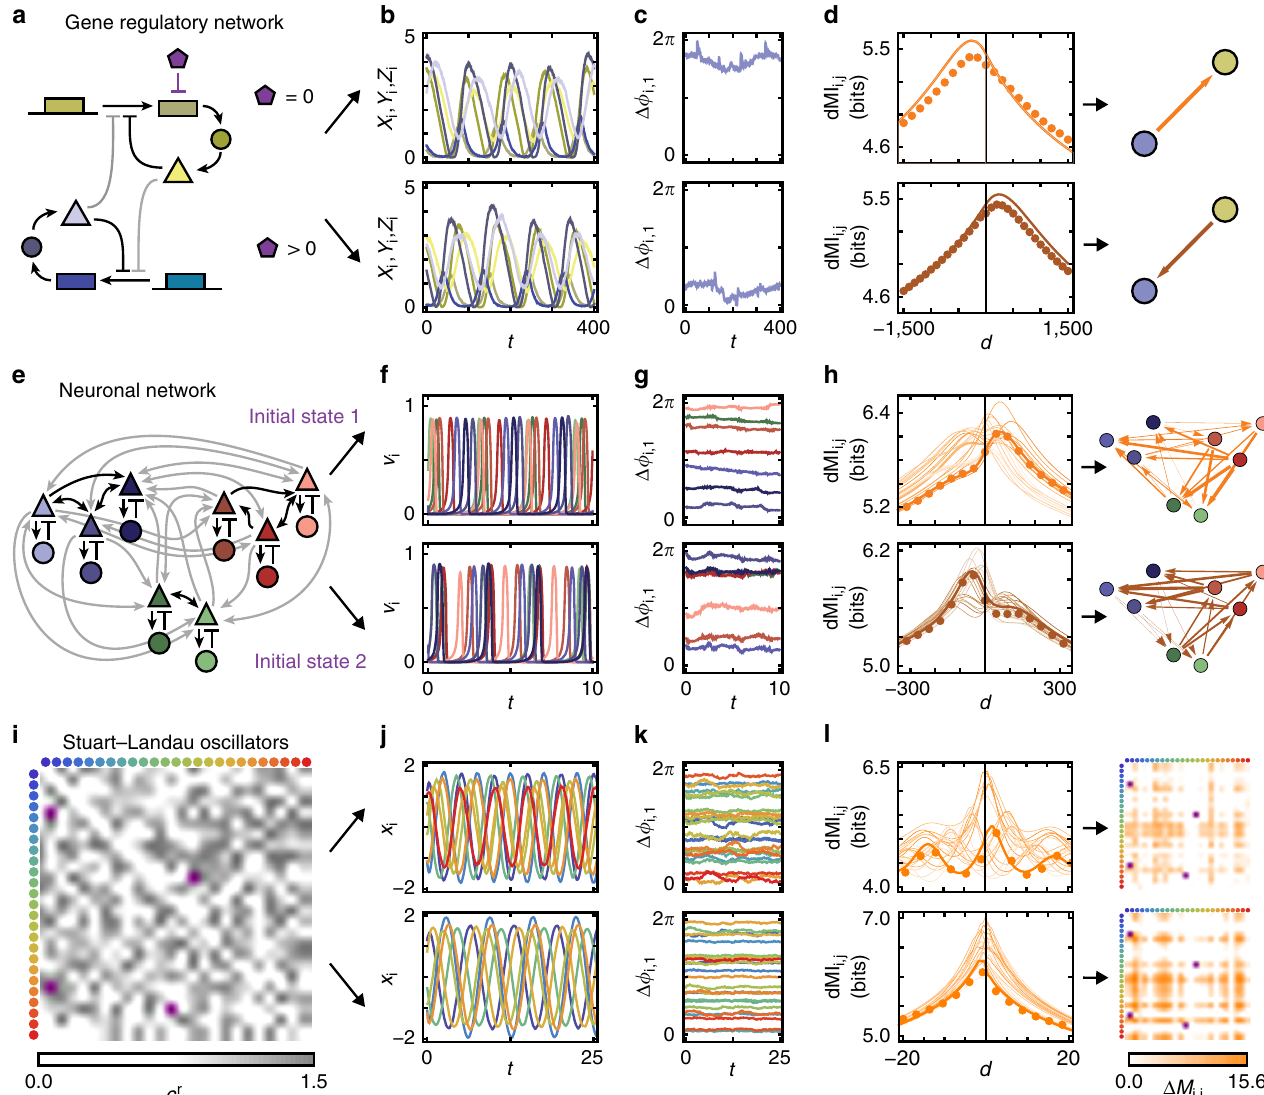
Figure 1 | Flexible information routing across networks. ( a ) Simple model of a gene-regulatory network of two coupled biochemical oscillators of Goodwin type (yellow and blue). An additional molecule (purple) degrades the transcribed mRNA in one of the oscillators and thereby changes its intrinsic frequency. Coupling strengths are gray coded (darker colour indicates stronger coupling), sharp arrows indicate activating and blunt arrows inhibiting influences (cf. Methods). ( b ) Stochastic oscillatory dynamics of the concentrations of the systems components x i (mRNA), y i (enzyme), and z i (protein), i A {1, 2}. ( c ) Fluctuations of the phases extracted from the full dynamics relative to a reference unit. ( d ) dMI (dMI 1,2 ) between the phase signals. The numerical data (dots) agrees well with the theoretical prediction (4) (solid lines). The asymmetry in the dMI curves around d ¼ 0 indicates a directed information sharing pattern summarized in the graphs (right). Arrow thickness indicates the strength of directed information sharing D MI i , j measured by the positively rectified differences of the areas below the dMI i , j ( d ) curve for d o 0 and d 4 0. ( e – h ) Same as in a – d but for a modular network of coupled neuronal sub-populations consisting each of excitatory (triangle) and inhibitory (disk) populations (Wilson–Cowan-type dynamics) that undergo neuronal oscillatory activity (cf. Methods). For the same network two different collective dynamical states accessed by different initial conditions give rise to two different information sharing patterns ( f – h top versus bottom). ( f ) Oscillatory activities v i of the N ¼ 8 excitatory populations i . ( i – l ) As in a – d but for generic oscillators close to a Hopf bifurcation (Stuart–Landau oscillators) each described by two-dimensional normal-form coordinates ( x i , y i ) connected to a larger network of N ¼ 25 oscillators with coupling coefficients c i,j r (cf. Methods). In i and l , connectivity matrices are shown instead of graphs. Two different network-wide IRPs arise (top versus bottom in j – l ) by changing a small number of connection weights (purple entries in i and l ). NATURE COMMUNICATIONS|7:11061|DOI: